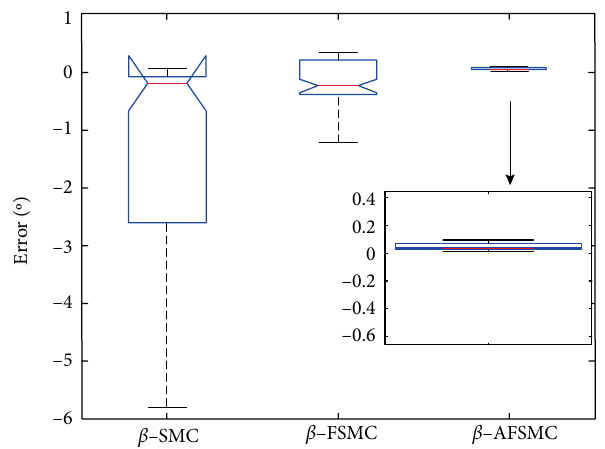
with three controllers. 𝛼